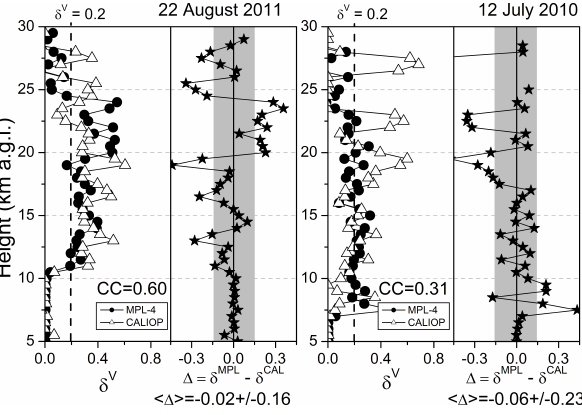
Fig. 11. The same as for Fig. 8, but for the CALIPSO D4 dis- tance range (70–90km). PSC events correspond to those cases with a high/moderate and low CC values as observed, respectively, on 31 July 2010 (left) and 22 June 2011